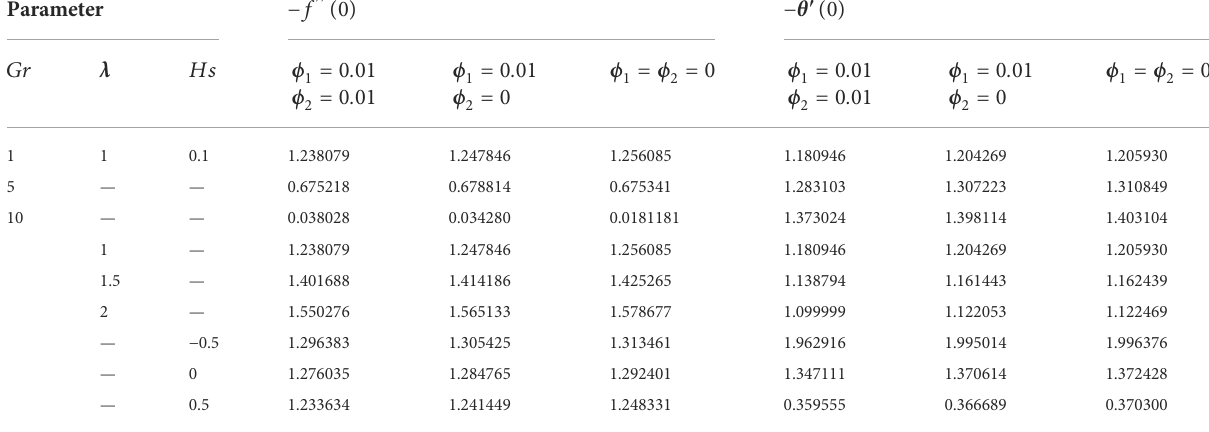
TABLE 4 Change in f 99 ( 0 ) and θ 9 ( 0 ) for various parameters in the wedge when Sc (cid:3) 0 . 8 , Kc (cid:3) Ks (cid:3) 0 . 1. Parameter